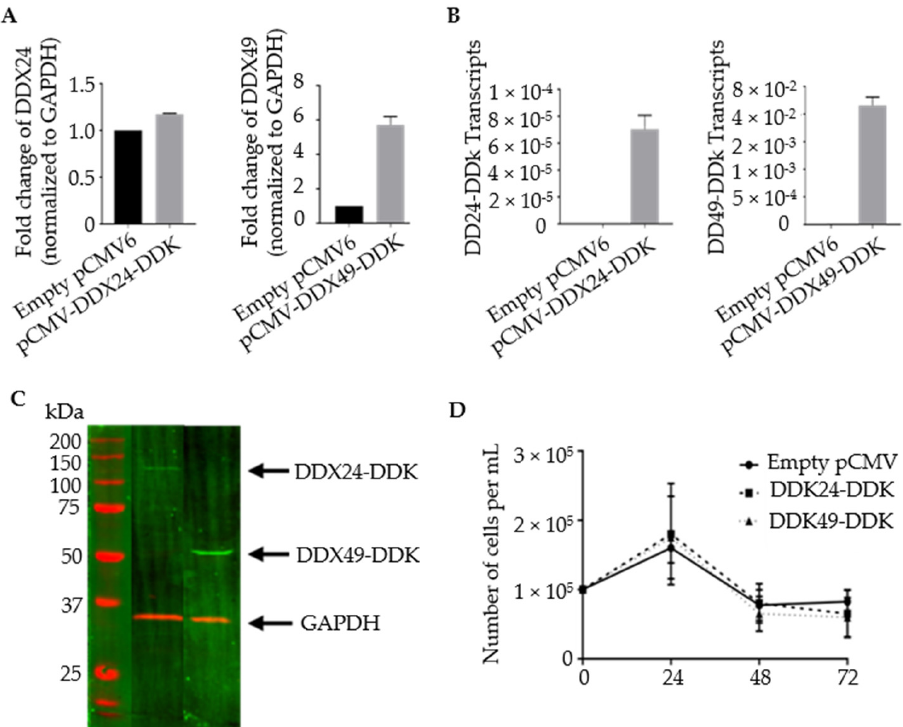
Figure 2. Validation of stably transfected BCBL-1 cells overexpressing DDX24-DDK and DDX49-DDK. ( A ) Relative transcript abundance of DDX24 and DDX49. Primers target gene body of endog-